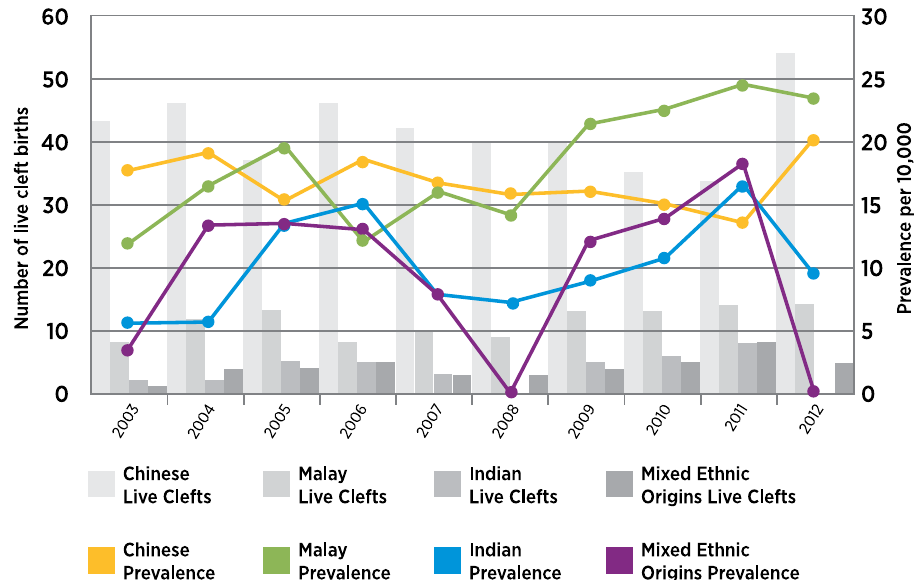
Figure 1. Population-based live cleft births by ethnic groups. Chinese group 17.17 per 10,000. Upward trend is not significant (p = 0.692). Malay group 16.92 per 10,000. Upward trend is significant (p = 0.008). Indian group 10.74 per 10,000. Upward trend is not significant (p = 0.724). Mixed ethnic origins group 21.73 per 10,000. Upward trend is not significant (p = 0.606).